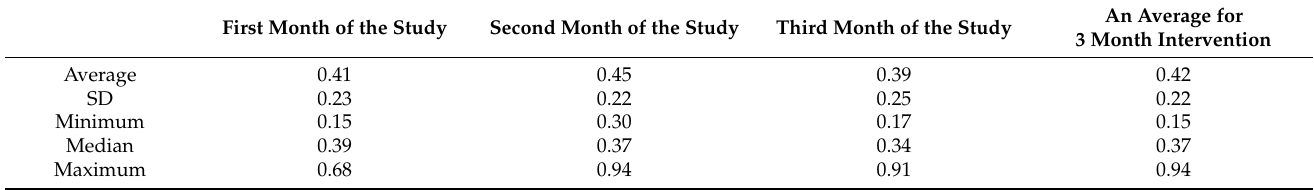
Table 9. Salicylate content in the nursing home menus